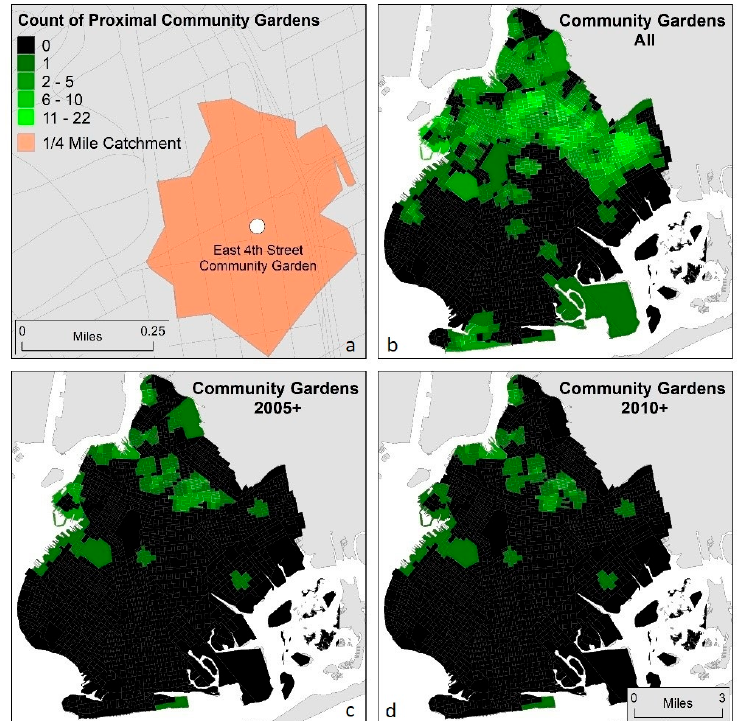
Figure 3. ( a ) The ¼ mile pedestrian-accessible catchment area (based on network analysis) around one community garden (East 4th Street Community Garden); ( b ) counts of number of community gardens (founded any year) within ¼ mile of each block group; ( c ) counts of number of community gardens (founded in 2005 or later) within ¼ mile of each block group; and( d ) counts of number of community gardens (founded in 2010 or later) within ¼ mile of each block group. Hot spots (clusters of block groups with higher counts of proximal community gardens) were then calculated using the Getis–Ord Gi* statistic [64] with the distance threshold set at ¼ mile. This distance was selected to be consistent with the ¼ mile walkable neighborhood distance threshold of the network analysis, and to capture the spatial process of interest. Lower-income block groups with confidence values of 95% and above were retained for analysis. This output represents a characterization of proximity to community gardens at a different scale from the block group analysis, capturing a less localized version of the phenomenon (see Figure 4).